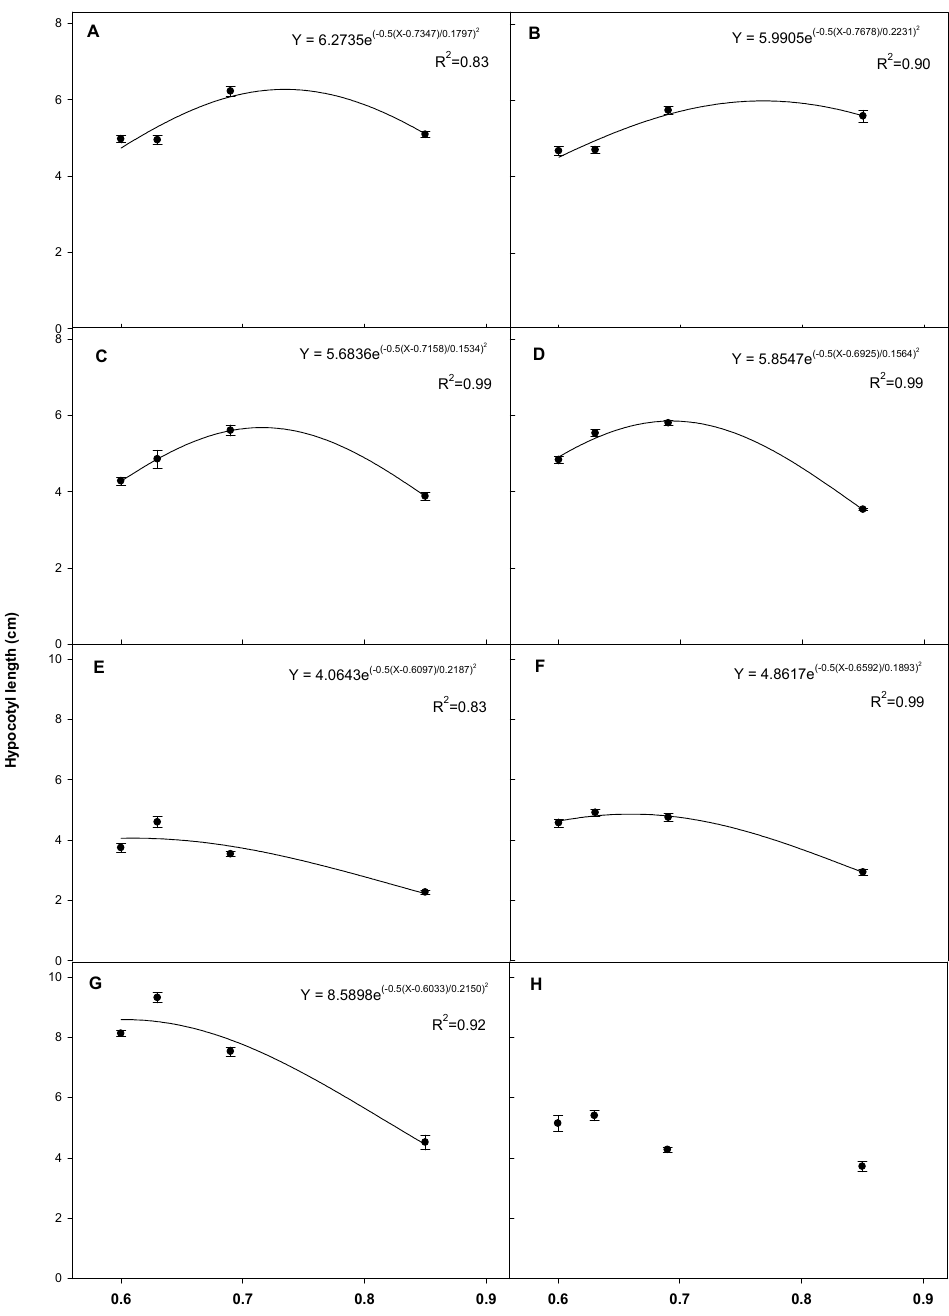
Figure 4. Regression of hypocotyl length with phytochrome stationary state (PSS). The value of each point is the average hypocotyl length of “Dotaerangdia” ( A ) and “B-blocking” ( B ) tomato at 14 days after sowing (DAS), “Shinhong” ( C ) and “Tantan” ( D ) red pepper at 14 DAS, cucumber ( E ) and gourd ( F ) at 7 DAS and watermelon ( G ) and bottle gourd ( H ) at 9 DAS by the different supplemental far-red-enriched LED lighting treatments. Data represent the mean of three replications with eight plants per replication per species/cultivar. Vertical bars represent standard errors of means.